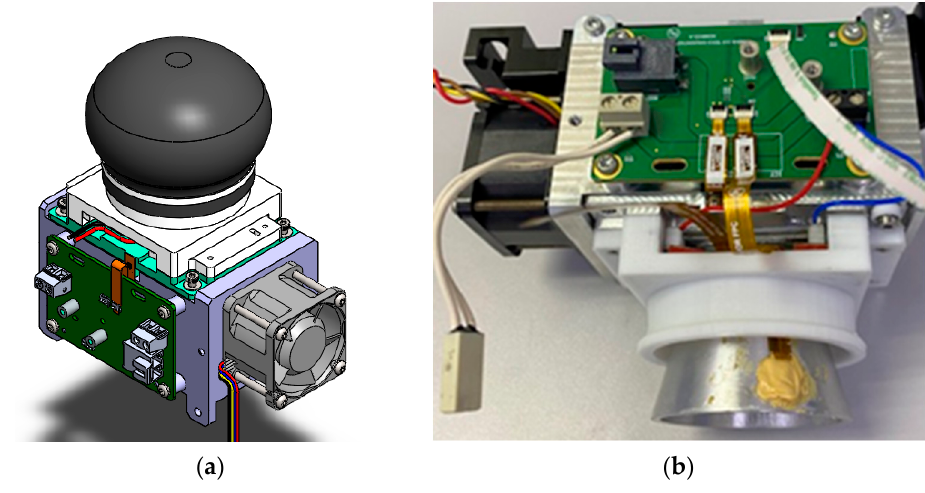
Figure 6. ( a ) Final design of integrated liquid jammer; ( b ) prototype sample.